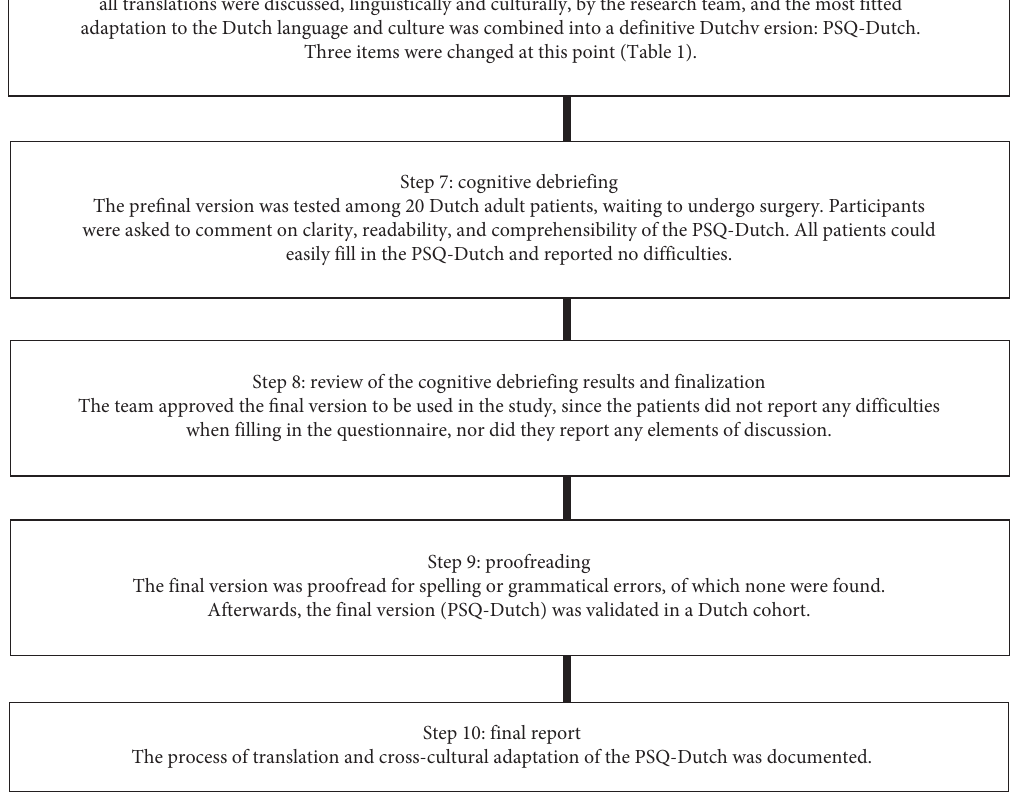
Figure 1: Flow diagram of the translation and cross-cultural adaptation